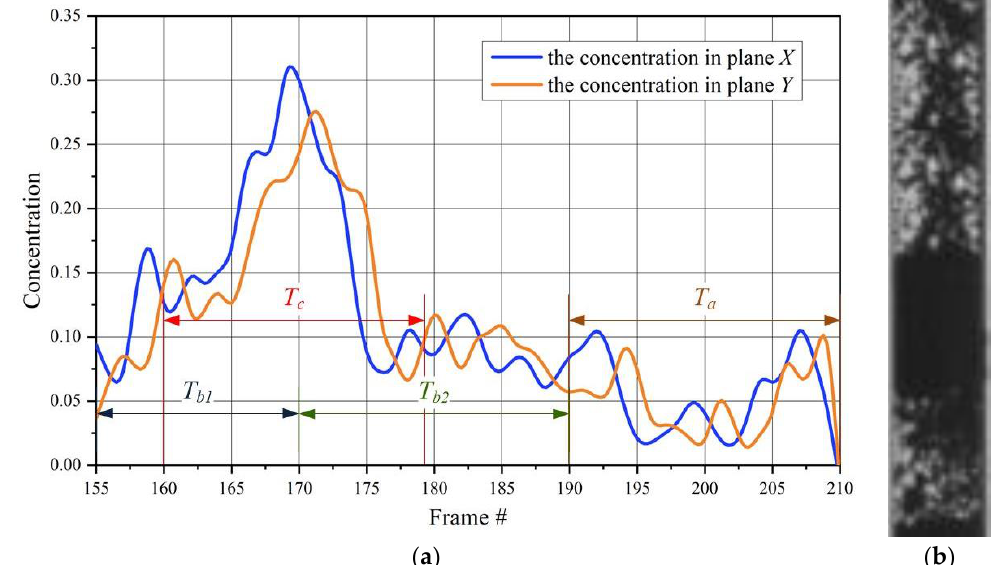
Figure 2. Normalized concentration changes within chosen pixel (12,12) of the tomographic images ( a ) and image captured by high-speed camera (#150-#205) ( b ); T a/b/c —the fixed time window.